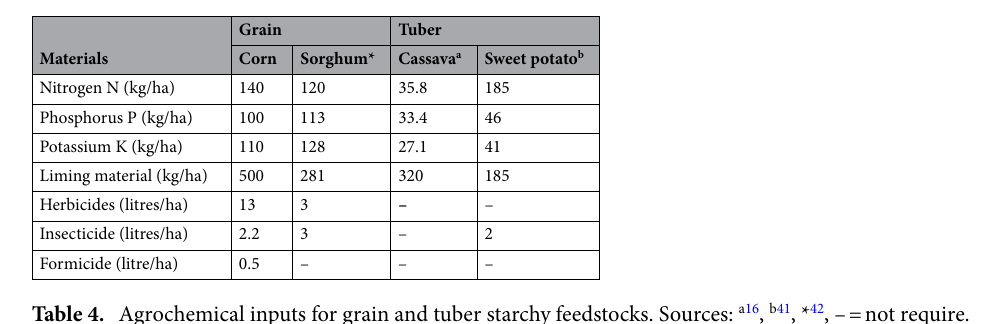
Table 4. Agrochemical inputs for grain and tuber starchy feedstocks. Sources: a16 , b41 , * 42 , – = not require.